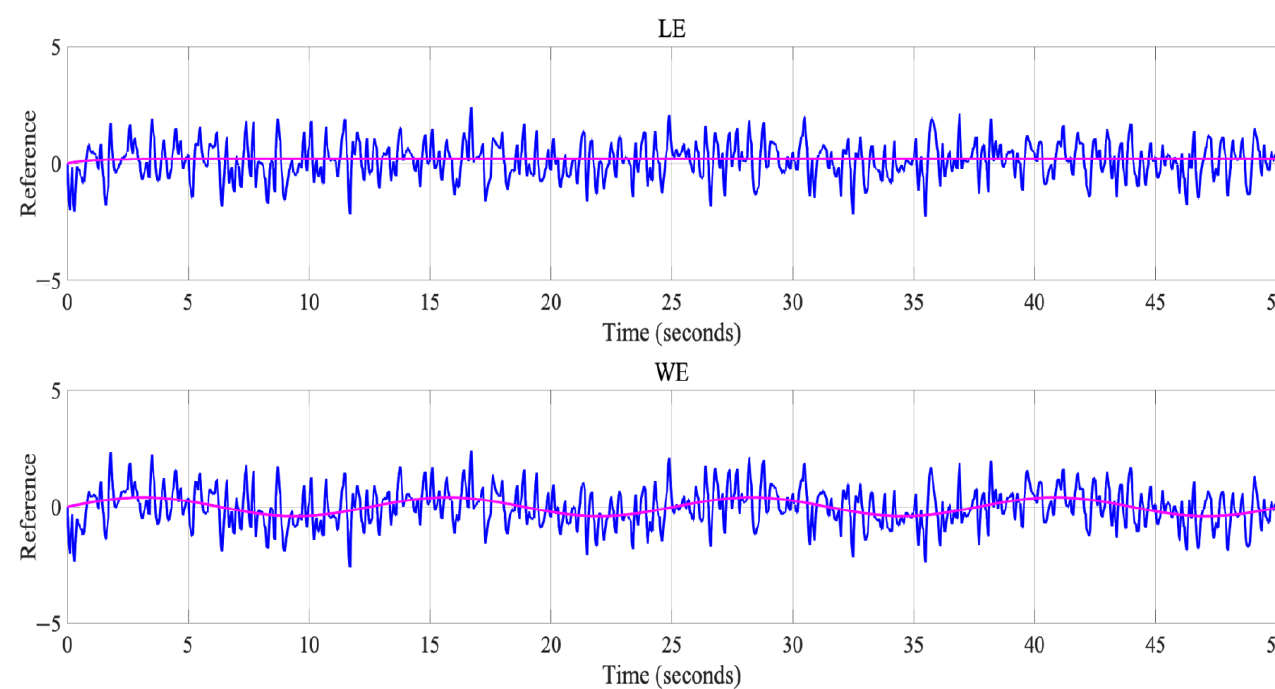
Figure 11. Representation of the best result representing the LE and the WE. Finally, the trajectories of the LE and the WE for disturbance 3 are represented in Figure 12. In this case, it was observed that they had a small variation with respect to the desired line.